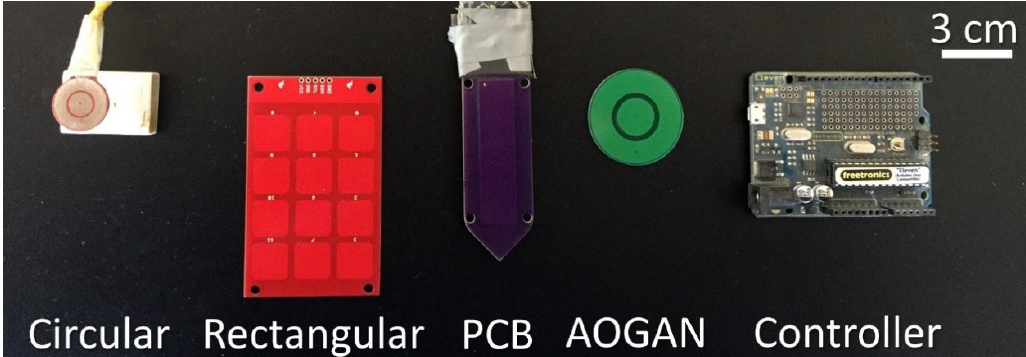
Figure 1. Capacitive sensors: Circular, Rectangular, PCB Gadget (PCB) and AOGAN sensors (left to right). The Arduino-based board controller is also shown to the right.